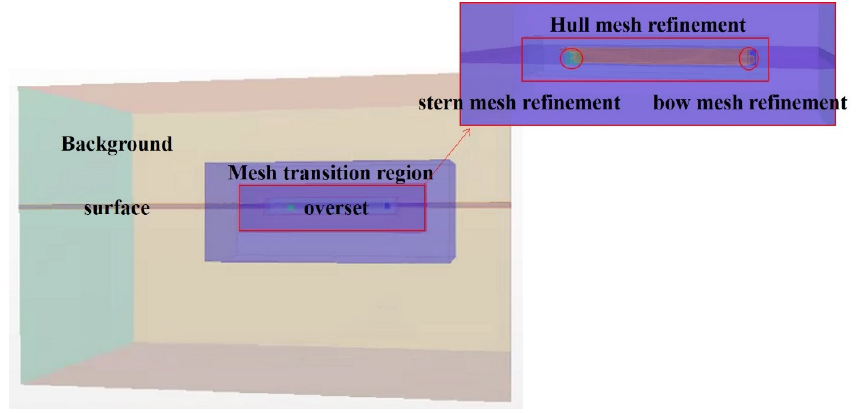
Figure 4. Overset mesh drawing method.